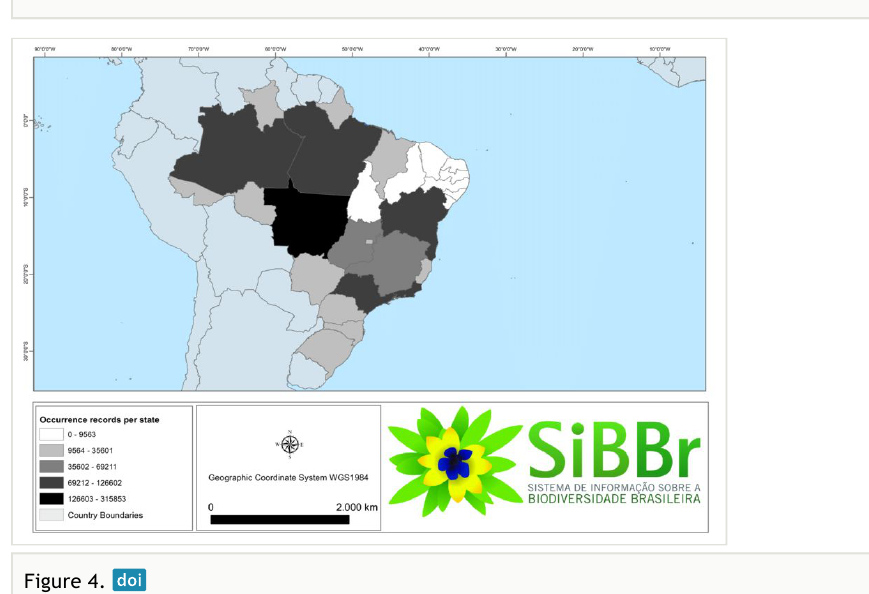
Figure 4. Geographic coverage by records of occurrence by Brazilian state of the repatriated data